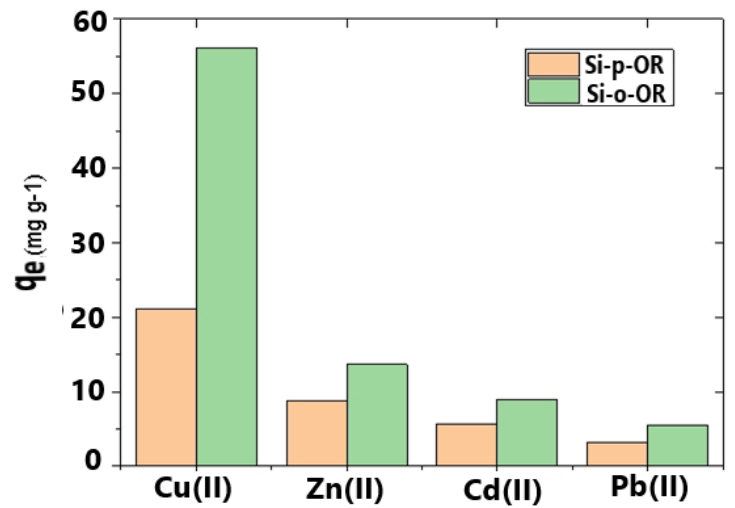
Figure 10. Metal ion selectivity effect using Si-o-OR and Si-p-OR .